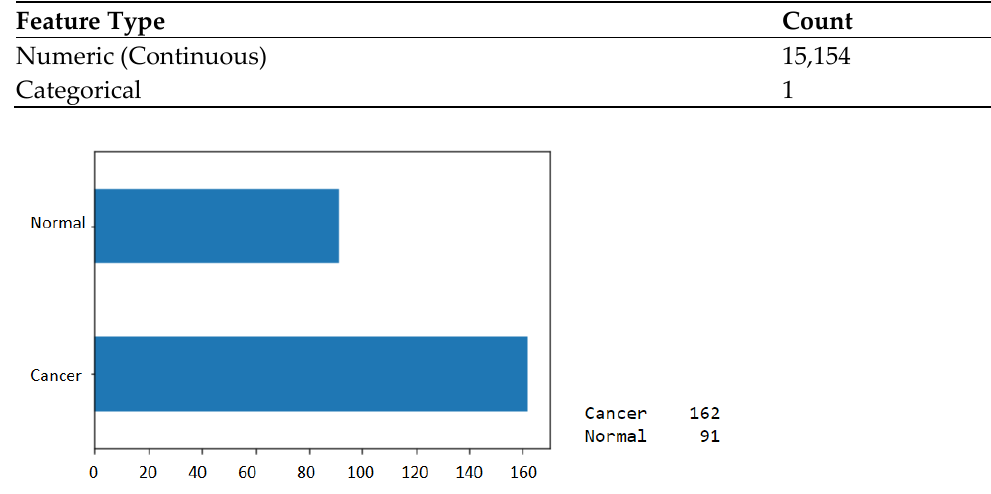
Table 2. Feature types and number of features in the Ovarian Dataset.